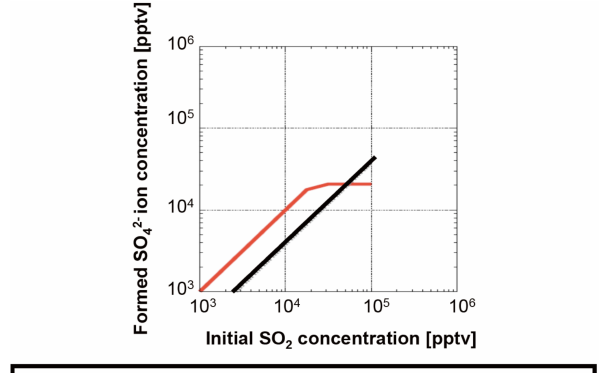
Fig. 4. An example of predicted sulfate concentrations through the SO 2 aqueous-phase oxidation during twenty minutes for the con- ditions of 300 K and 5ppbv H 2 O 2 . The x-axis values are initial SO 2 concentrations and the y-axis values are sulfate concentration formed from SO 2 oxidation by H 2 O 2